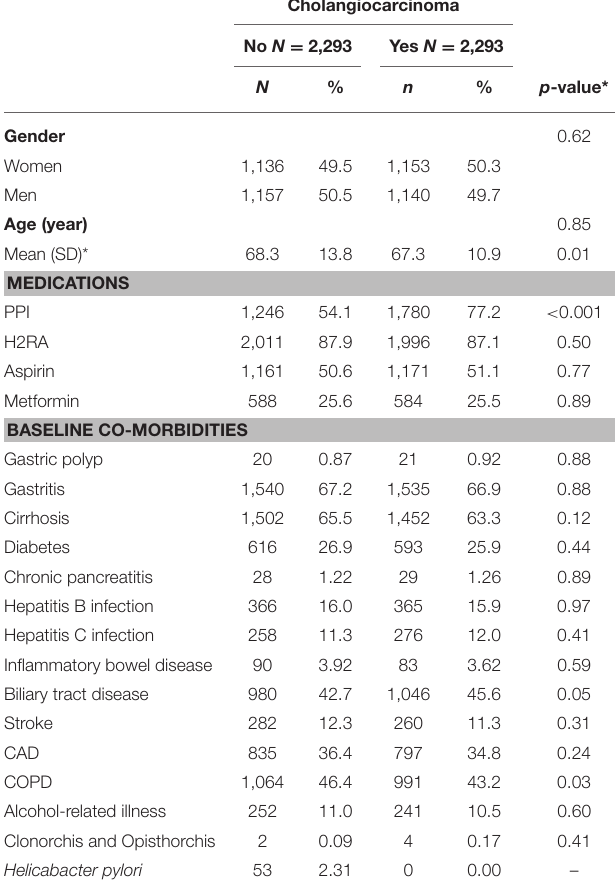
TABLE 2 | Odds ratios and 95% confidence intervals of cholangiocarcinoma associated with proton pump inhibitor and covariates.